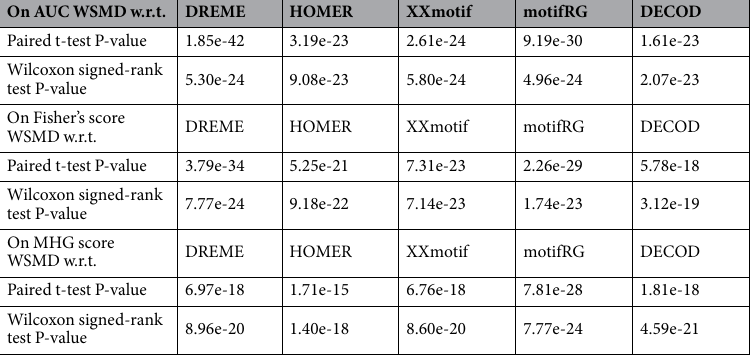
Table 2. The paired t-test and Wilcoxon signed-rank test P-value between WSMD and the other methods on different evaluation criteria.